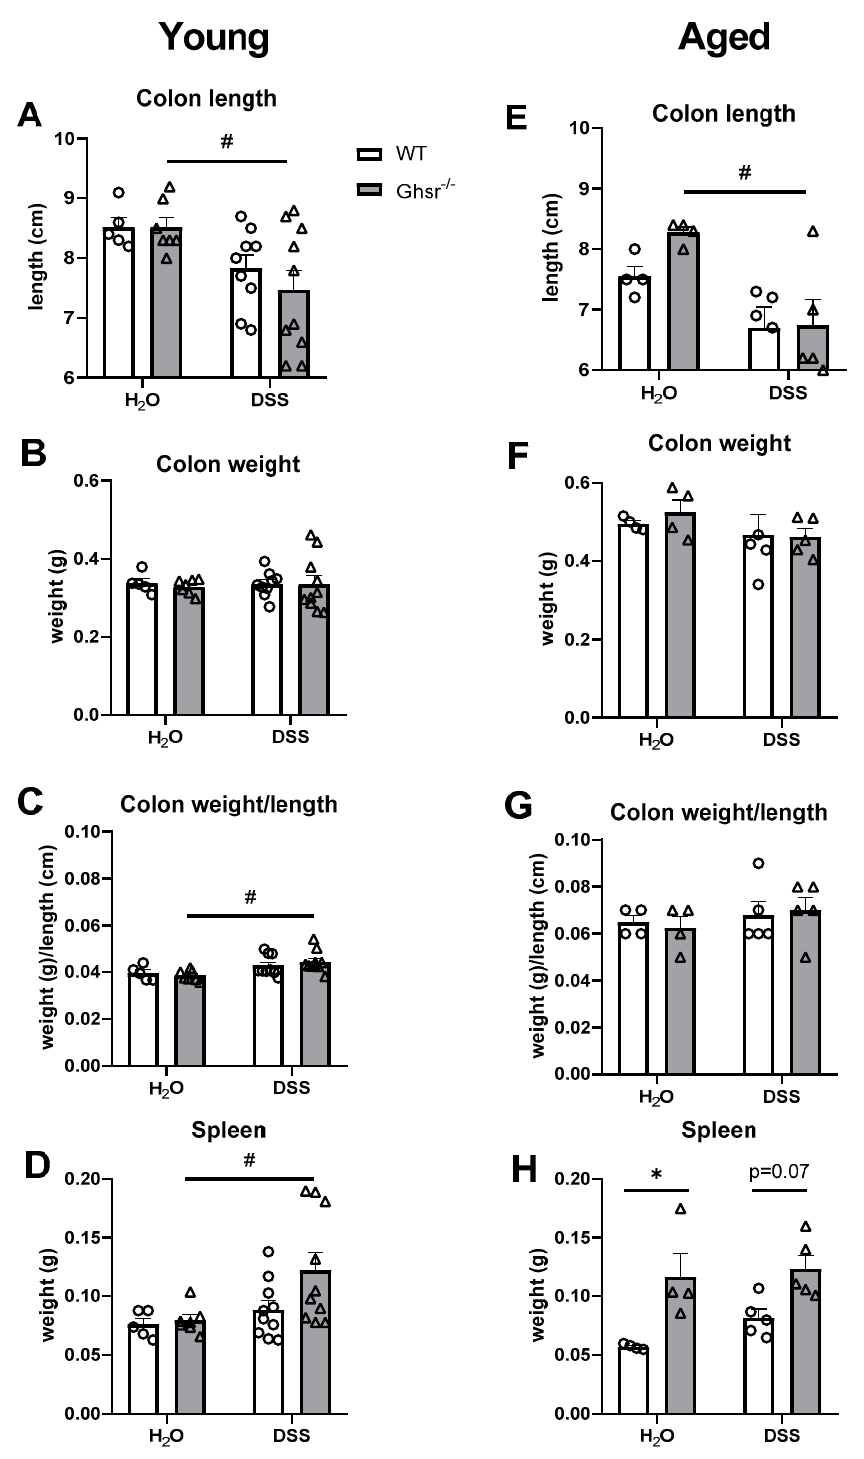
Figure 3. Tissue changes in young and aged Ghsr − / − mice under DSS-induced colitis. Young (4–6-month-old) or aged (18-month-old) male mice were exposed to 2% ( w / v ) DSS for 7 consecutive days. The left panels are from the young group and the right panels are from the old group. ( A , E ) Colon length, ( B , F ) colon weight, ( C , G ) colon weight/length ratio on termination day, ( D , H ) weight of spleen on termination day. n = 5–10 in young group, n = 4–5 in aged group. * p < 0.05, WT vs. Ghsr − / − . # p < 0.05, DSS vs. normal water in each genotype.